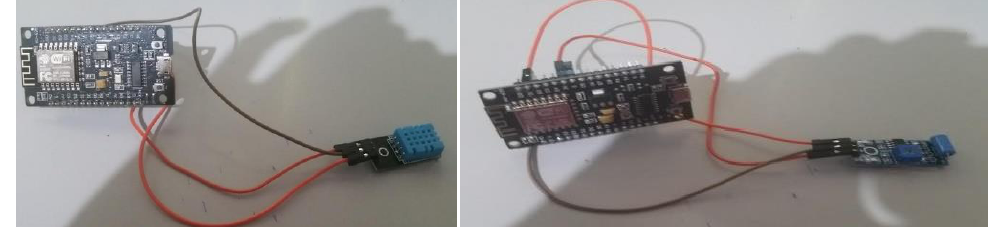
Figure 11. DHT11 wiring diagram with ESP8266